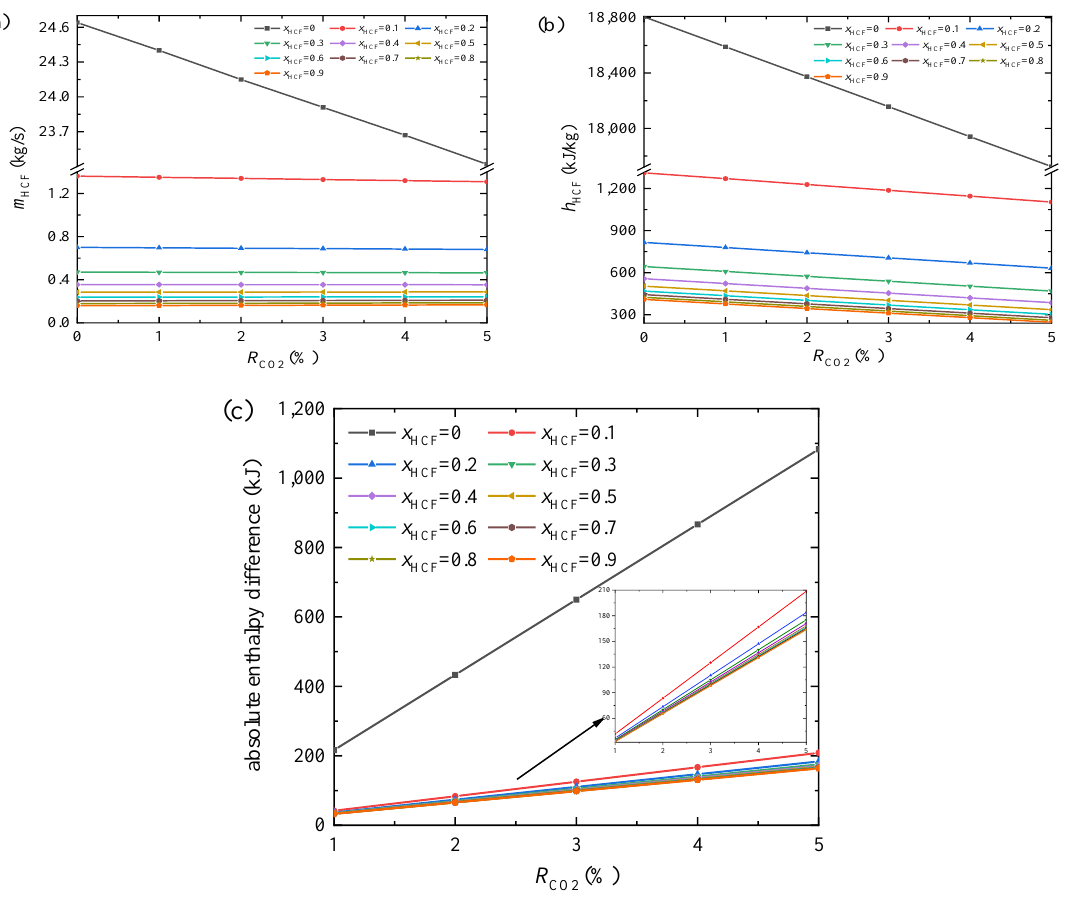
Figure 6. Variation curves of wellhead productivity parameters of heat carrier with R CO2 under different steam quality: ( a ) mass flow rate, ( b ) enthalpy and ( c ) absolute enthalpy difference.